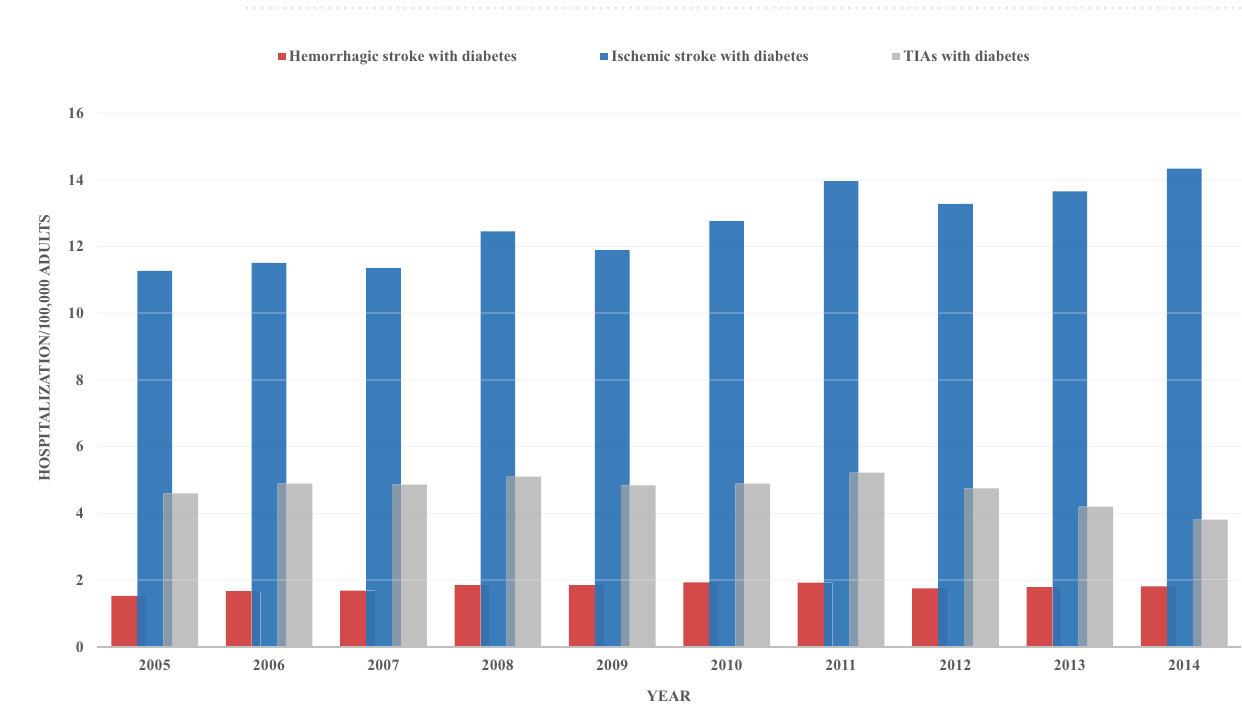
Table 1. Baseline demographics of diabetic patients admitted for stroke between 2005 to 2014.